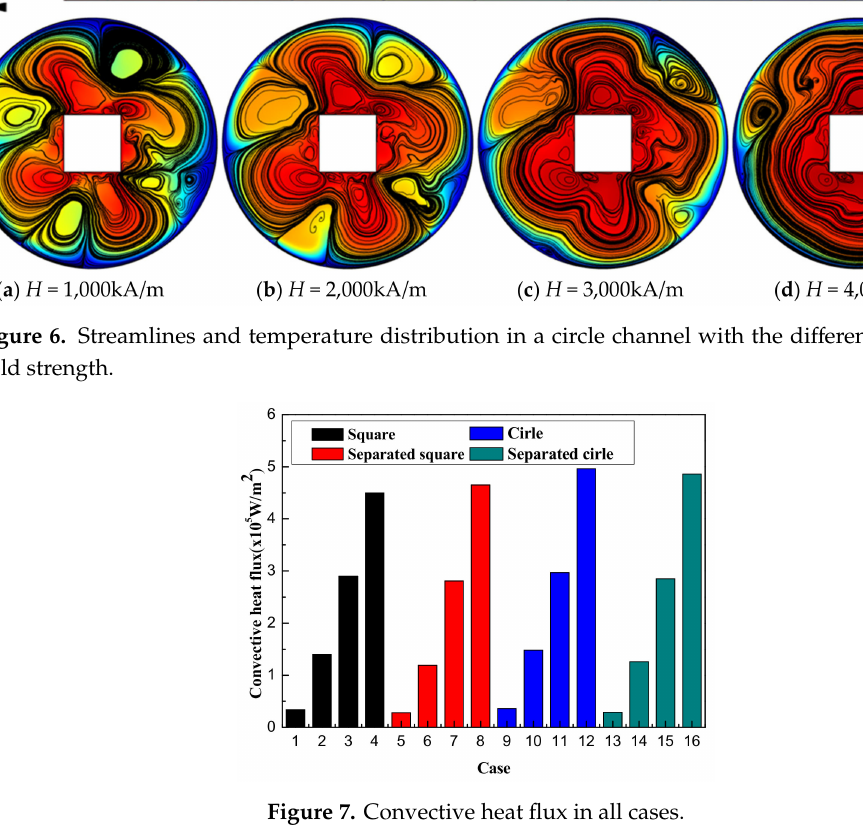
Figure 7. Convective heat flux in all